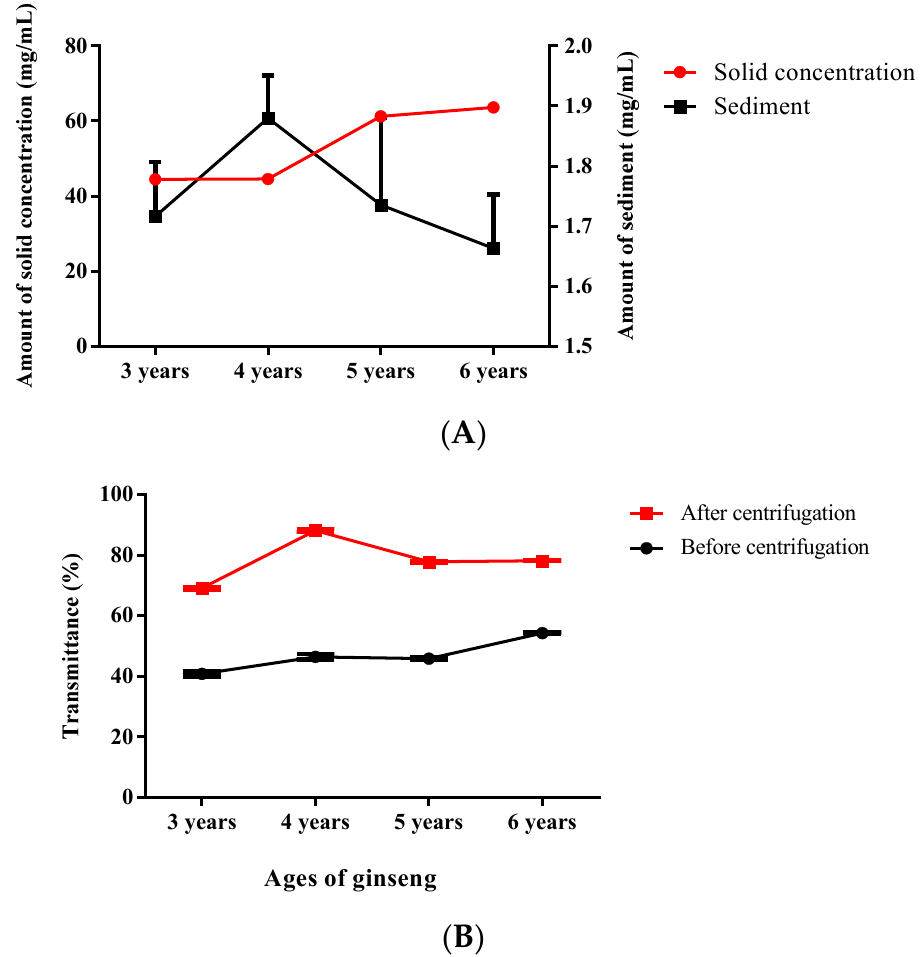
Figure 1. ( A ): Solid concentration and amount of sediment in ginseng extract of different ages, ( B ): the transmittance of ginseng extract of different ages before and after centrifugation. The data shown are the means of three replicates ( n = 3).